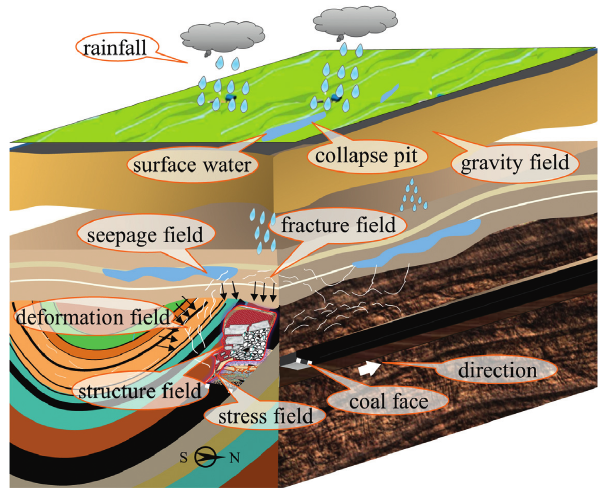
Figure 2: Schematic diagram of engineering geological multifield action of steeply inclined coal